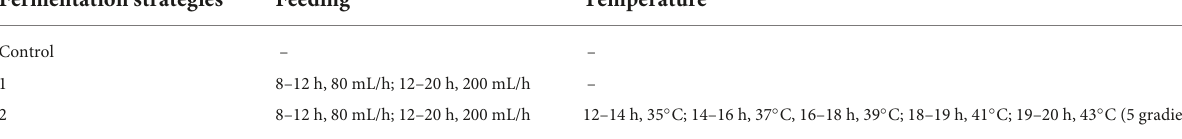
TABLE 1 Three fermentation control strategies. Fermentation strategies